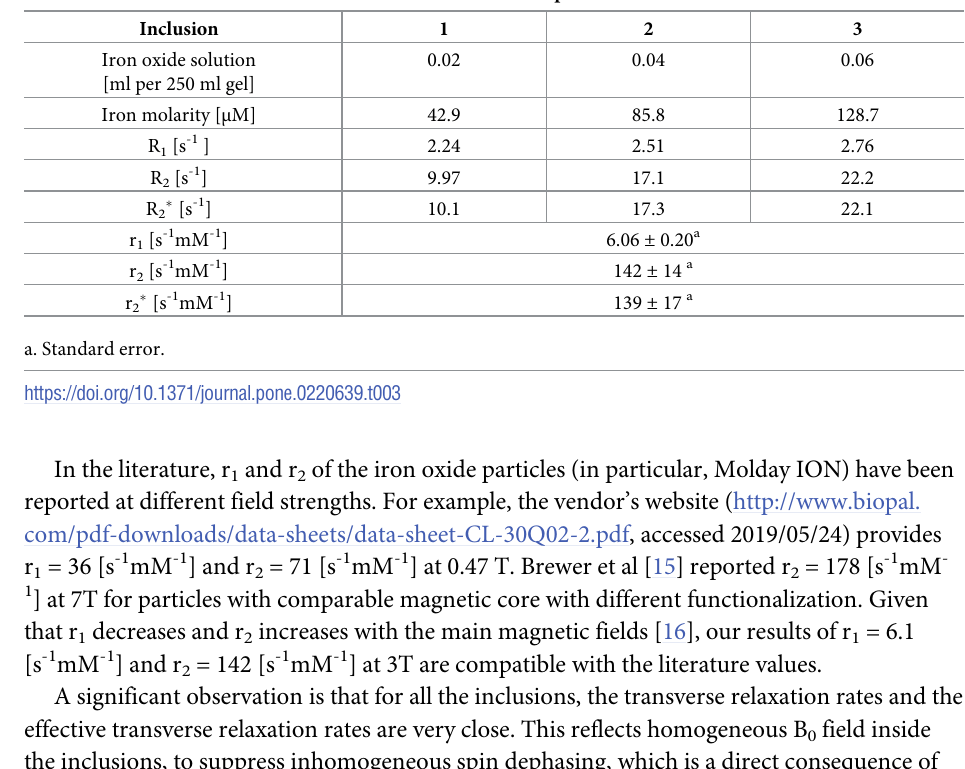
Table 3. Relaxation rates and relaxivities of the three inclusion